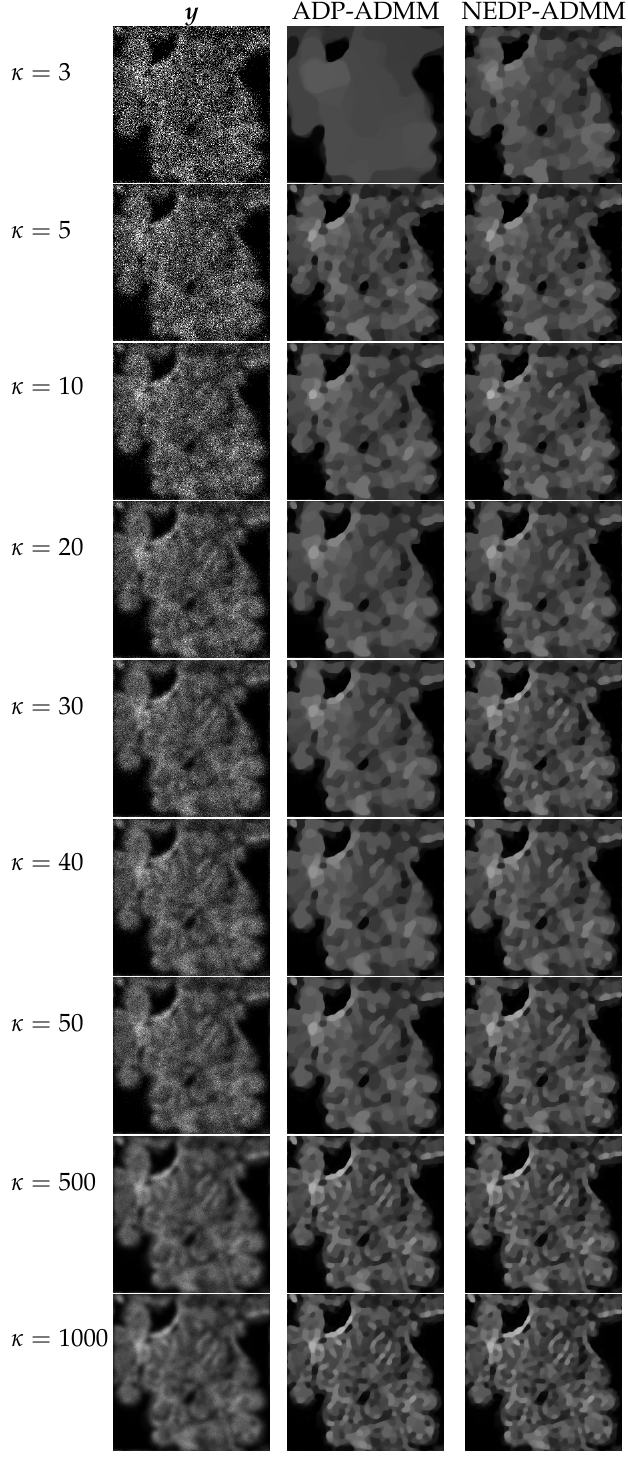
Figure 17. Test image cells . Left column: observed data y corrupted by Gaussian blur with parameters band = 13, sigma = 3 and Poisson noise with different κ -values ranging from 3 to 1000. Middle column: restorations by ADP-ADMM. Right column: restorations by